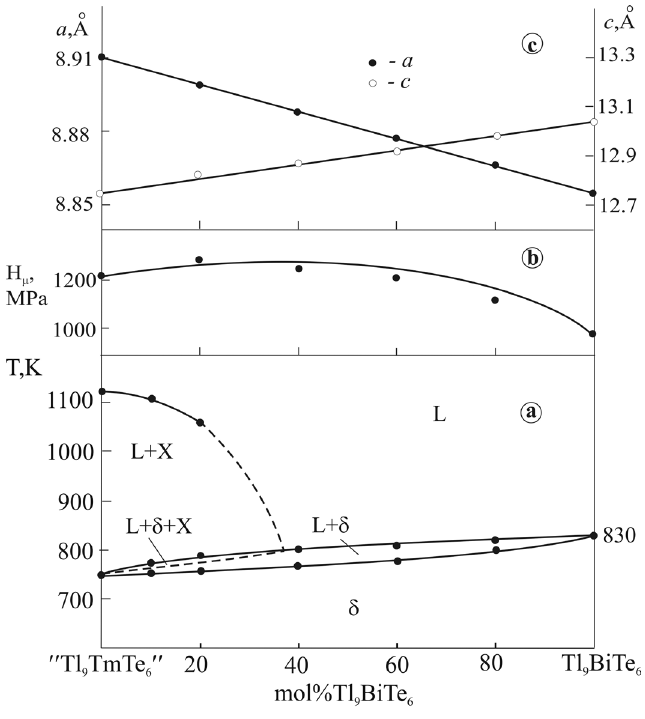
Figure 2. Phase diagram (a), concentration relations of microhardness (b), and lattice parameters (c) for the Tl